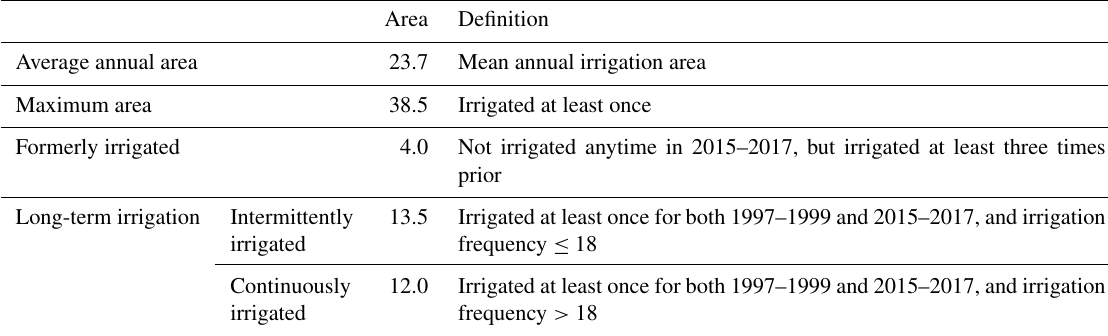
Table 3. Statistics of irrigation area (in 10 6 ha) across the CONUS for the period